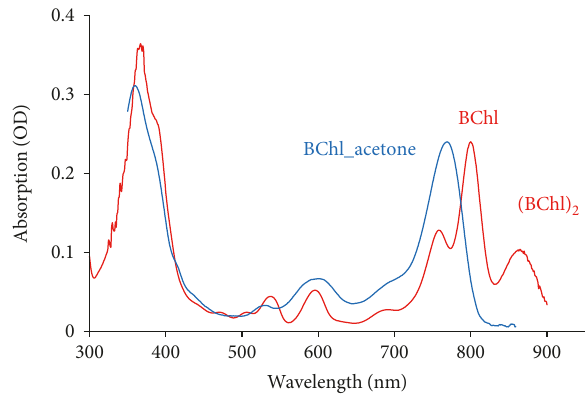
Figure 2: The absorption spectra of bacteriochlorophyll-a in organic solvent ( λ =770nm, ET-OH), bound to the RC in the max form of monomer (called “ accessory chlorophylls, ” λ and in the form of dimer (called primary electron donor, (BChl) λ max